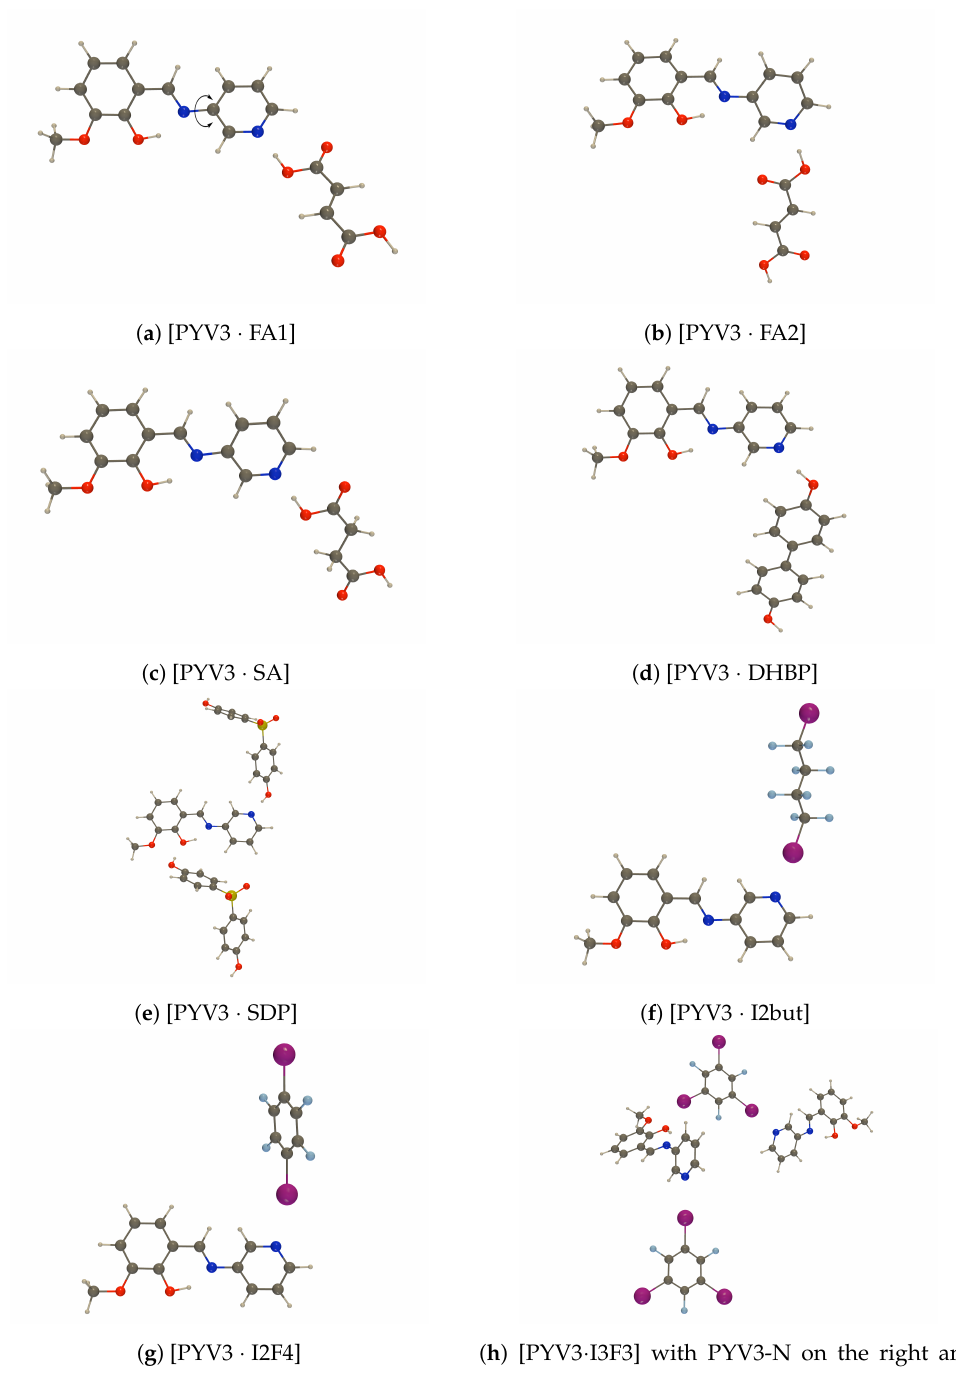
Figure 1. Representation of the PYV3-coformer synthons as extracted from the co-crystal structure optimized at the PBC/PBEsol0/6-31G(d,p)/I(LANL2DZ) level of approximation. Here, the enol